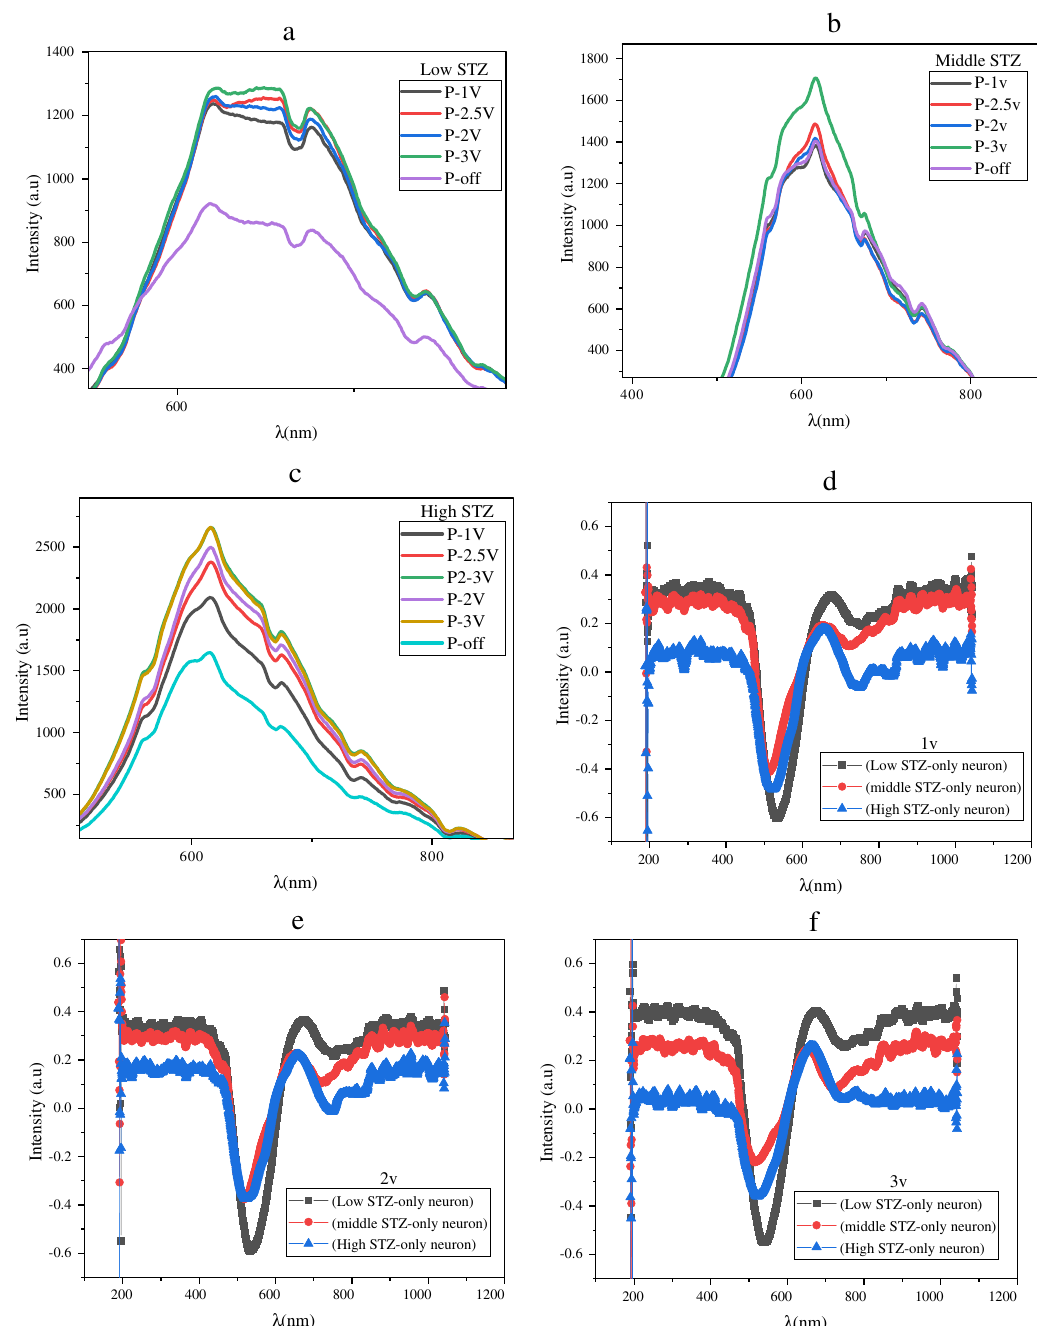
Figure 5. Show the activity of the cells under P polarization by applying an external voltage ( a ) With a low concentration of STZ, ( b ) With a middle concentration of STZ, ( c ) With a high concentration of STZ, ( d ) with applying 1 V and different concentration of STZ, ( e ) with applying 2 V and different concentration of STZ, ( f ) with applying 3 V and different concentration of